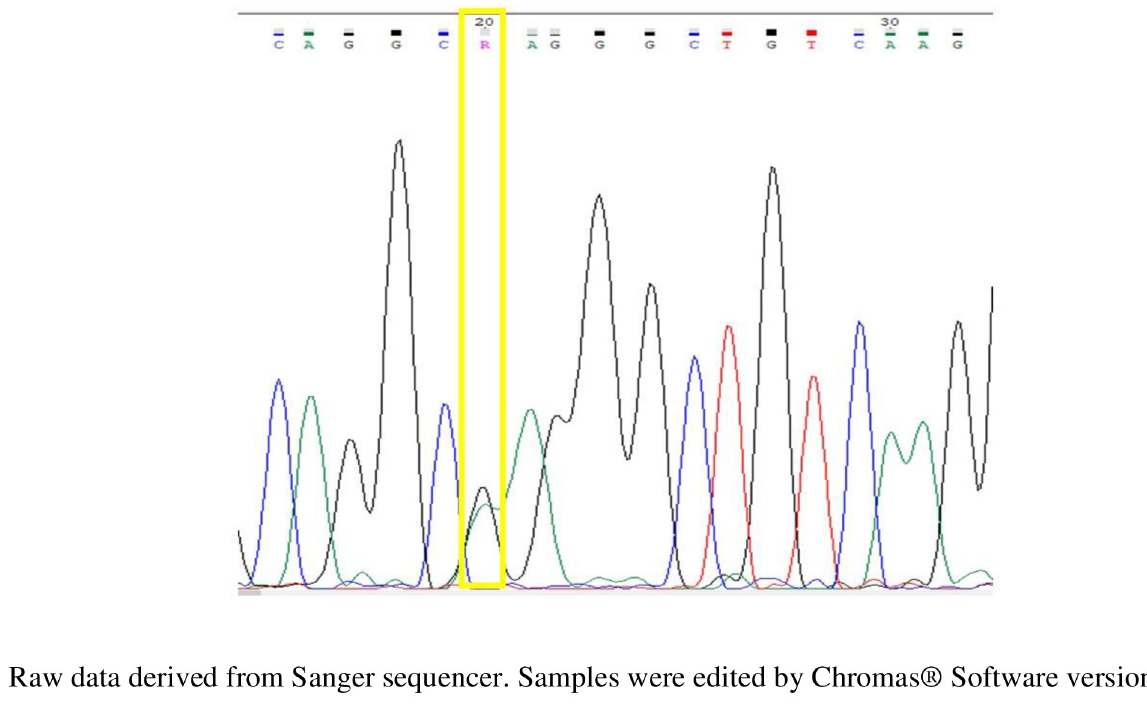
Fig 2. Sample of chromatogram data of rs10741657 showing the SNP- R (heterozygous G+A) allele in location 20 bp.